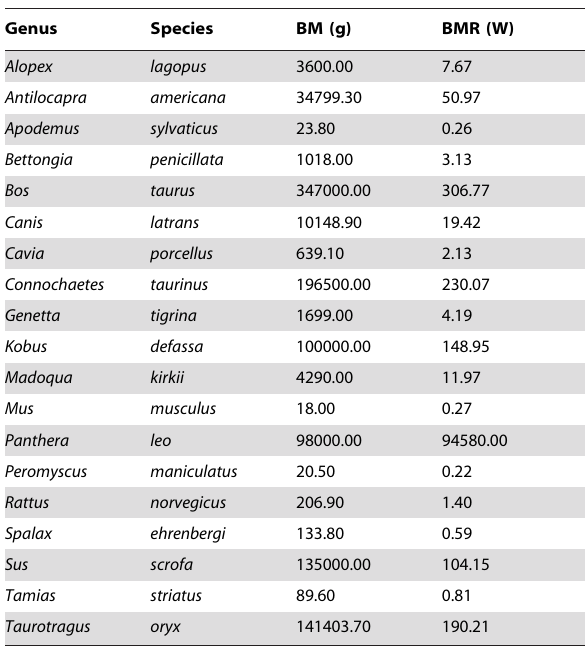
Table 3. Basal metabolic